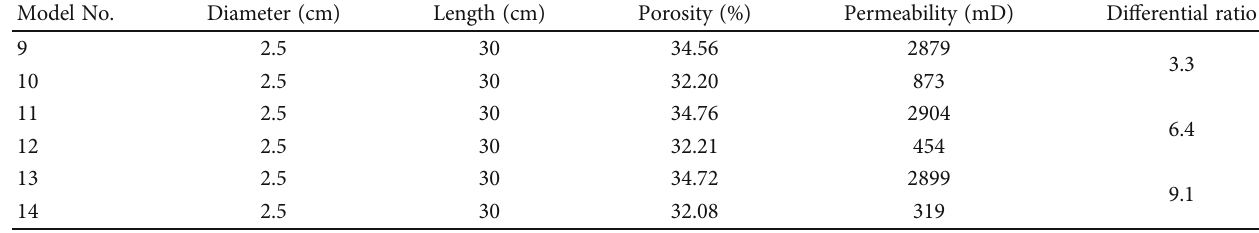
Table 2: Experimental parameters for dual-sandpack.